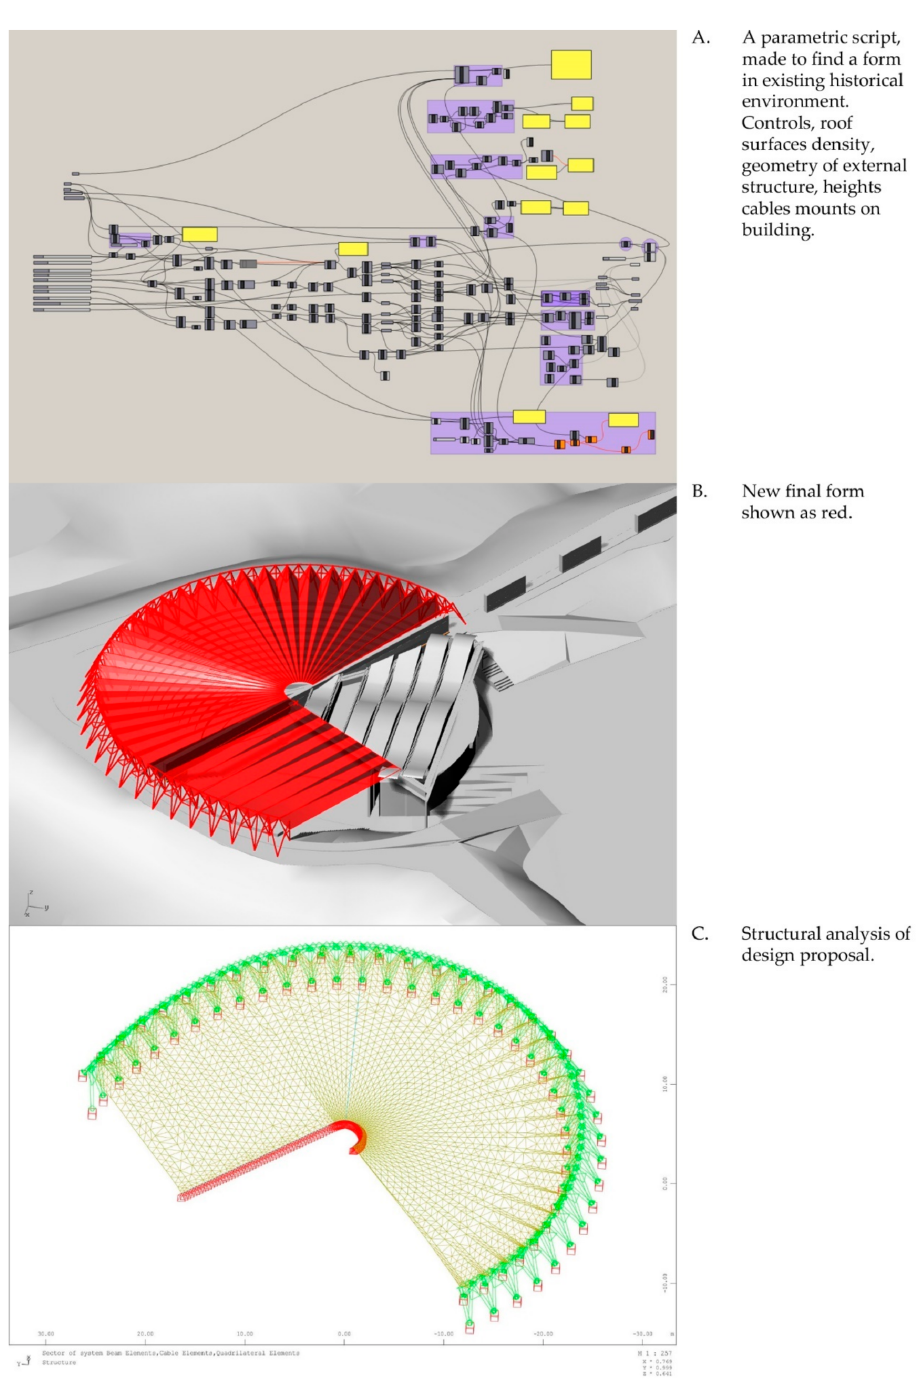
Figure 12. Parametric design of the shape ( A , B ) combined with structural analyze of the membrane and reaction of the foundations ( C ). Source: BP Projekt. The second type of membrane, Valmex Mehatop, produced by Mehler Texnologies, with similar parameters, was used to cover “light bridges” inside the